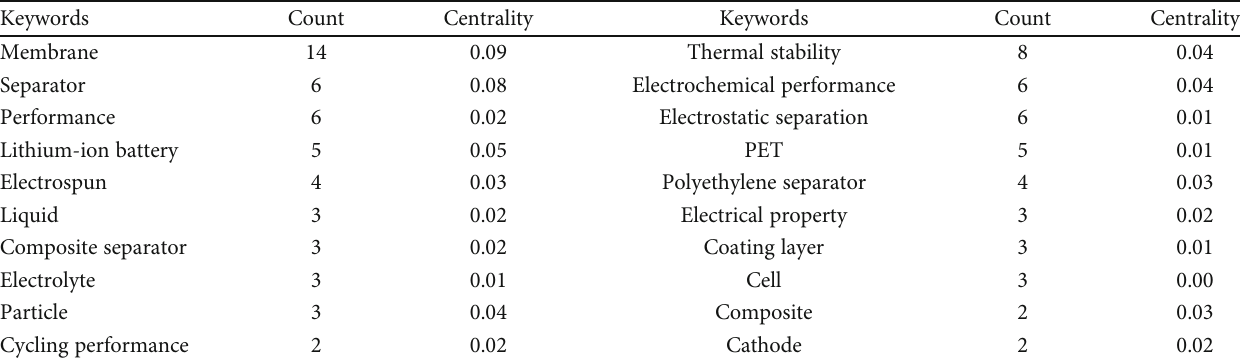
Figure 8: Annual distribution statistics visualization map of extracted keywords. Table 3: Top 20 keyword frequency distribution of published papers.